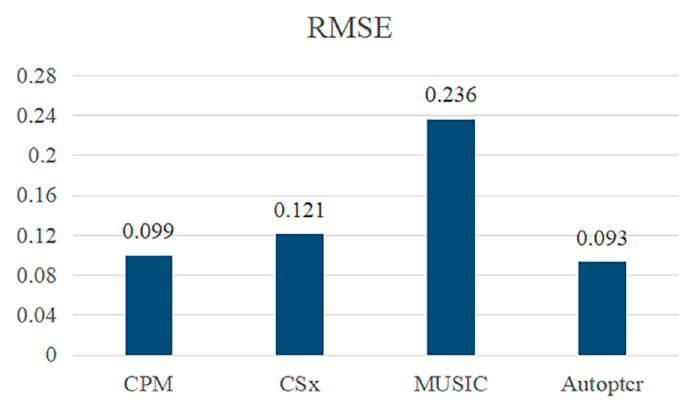
Figure 6. RMSE of CPM, CSx, MusiC, and Autoptcr on PBMC2.